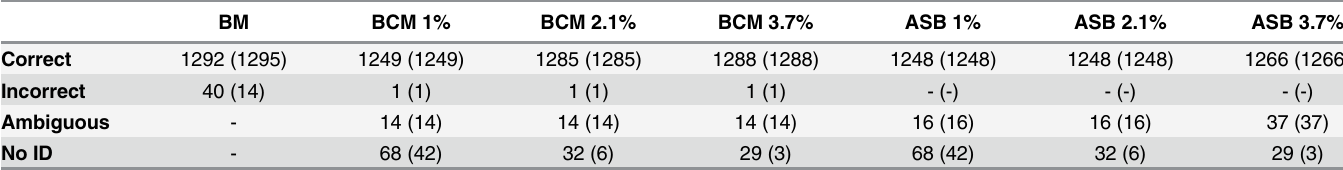
Table 3. Results of the identification simulations using Best Match (BM), Best Close Match (BCM) and All Species Barcode (ASB) criteria based on SPIDER. Correct and incorrect identifications indicate positive and negative outcome for the respective test. An “ ambiguous ” outcome corresponds to the presence of both correct and incorrect identifications within the threshold (ASB) or more than one equally close match with different identification including the correct one (BCM). A “ no ID ” outcome corresponds to no matches found within the threshold (both BCM and ASB). Values in brackets represent the results of simulation with the exclusion of